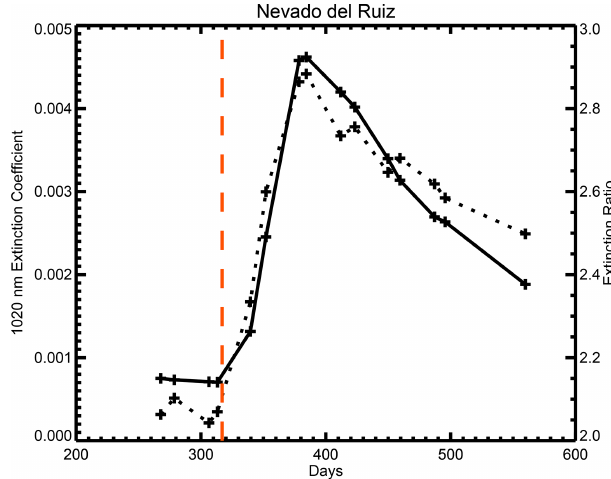
Figure 5. The same data as shown in Fig. 4a and b except now plot- ted as the 1020nm aerosol extinction coefficient (in km − 1 ) versus the extinction coefficient ratio. The extinction coefficient ratio is a rough estimate of the size of aerosol particles that dominate extinc- tion. Values near 1 suggest a particle radius greater than ∼ 0.4m with increasing values indicating smaller particles. Values for ob- servations prior to the eruption are red. All data are for 20.5km.